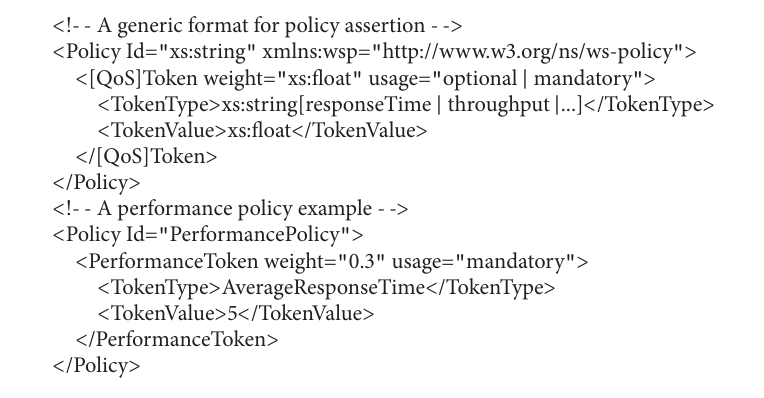
Algorithm 1: A generic format for service policy assertion.